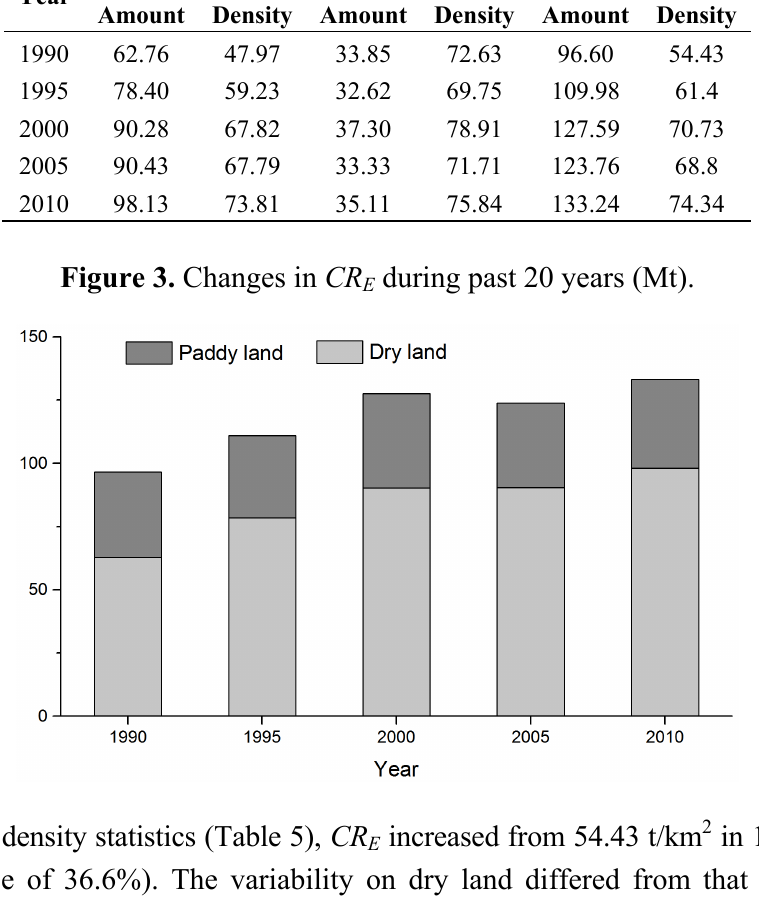
Table 5. Temporal changes in the amount (Mt) and density (t/km 2 ) of CR 1990 to 2010.